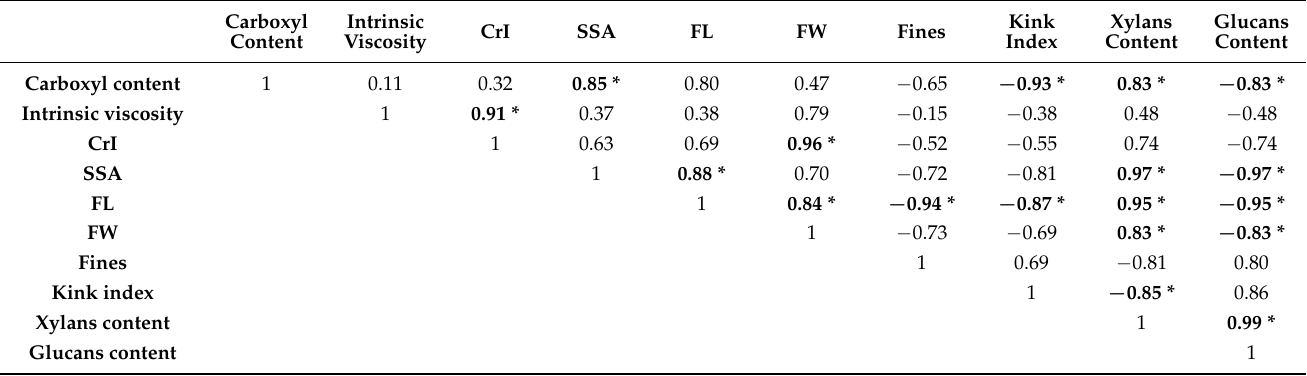
Table 2. Pearson correlation index between evaluated variables of the eucalyptus samples. n = 5.